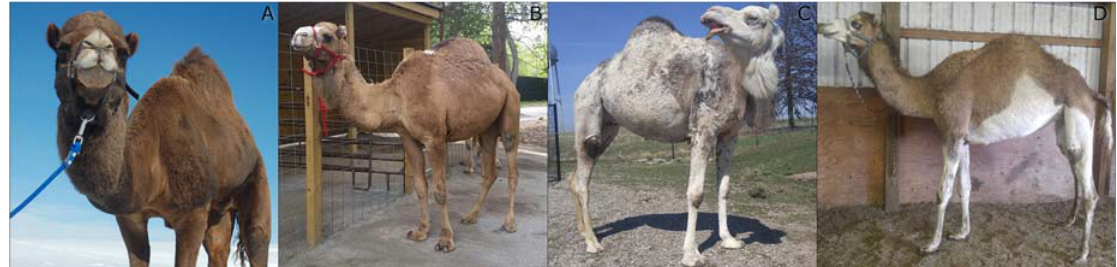
Figure 1. Range of white spotting phenotypes in this study. ( A ) A minimally spotted camel (US30), displaying white patches on both upper lips. ( B ) A minimally spotted camel (US25), showing a facial marking and white spot in front of the hump. ( C ) An extensively spotted “mottled white” camel (US28), with pigmented regions concentrated along the topline. ( D ) A moderately spotted “clear white” camel (US34), showing clear definition between pigmented and white regions.